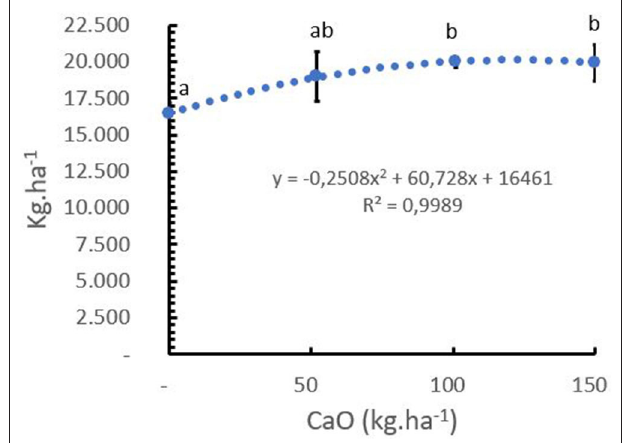
FIGURE 9 | Effect of calcium rates (kg CaO/ha) on yield in Coffea arabica L. cv. Castillo ® (mean yield from 2014 to 2018). Points represent the mean values for each of the replicates ± standard error. Different letters represent statistically significant differences among the treatments ( P < 0.05, LSD fisher).